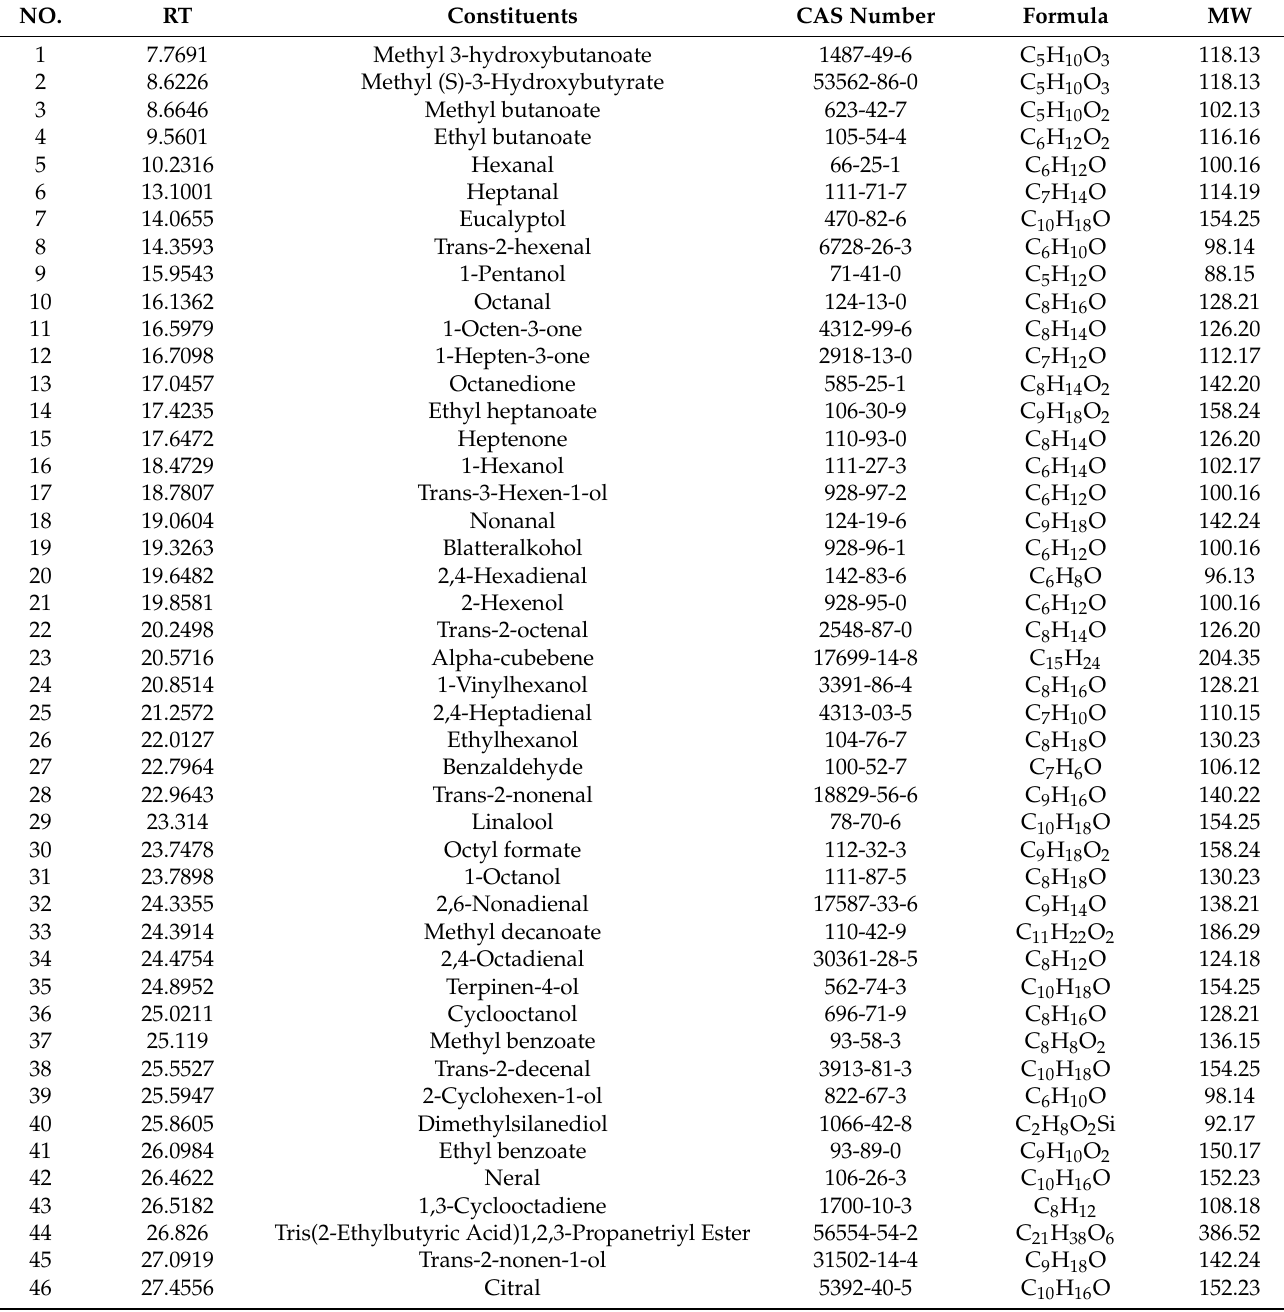
Table 1. Volatile flavor compounds in ‘Xuxiang’ kiwifruit during low-temperature storage at 2 ◦